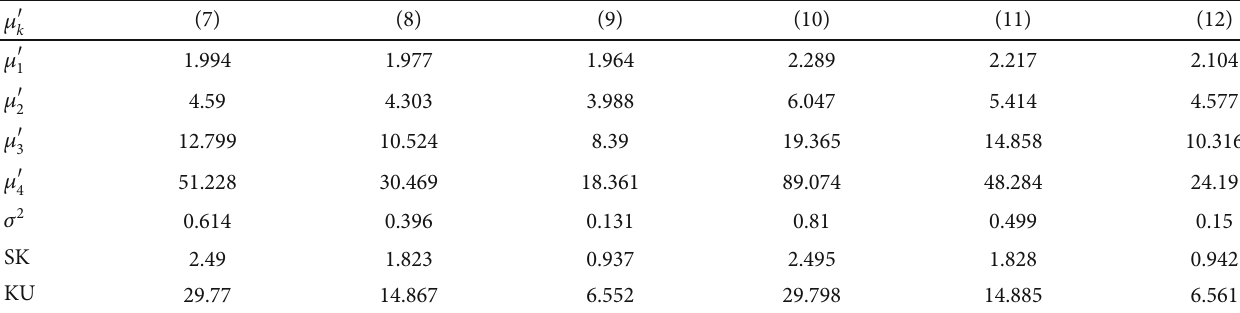
Table 2: First four moments, σ 2 , SK , and KU of X for some choices of parameter